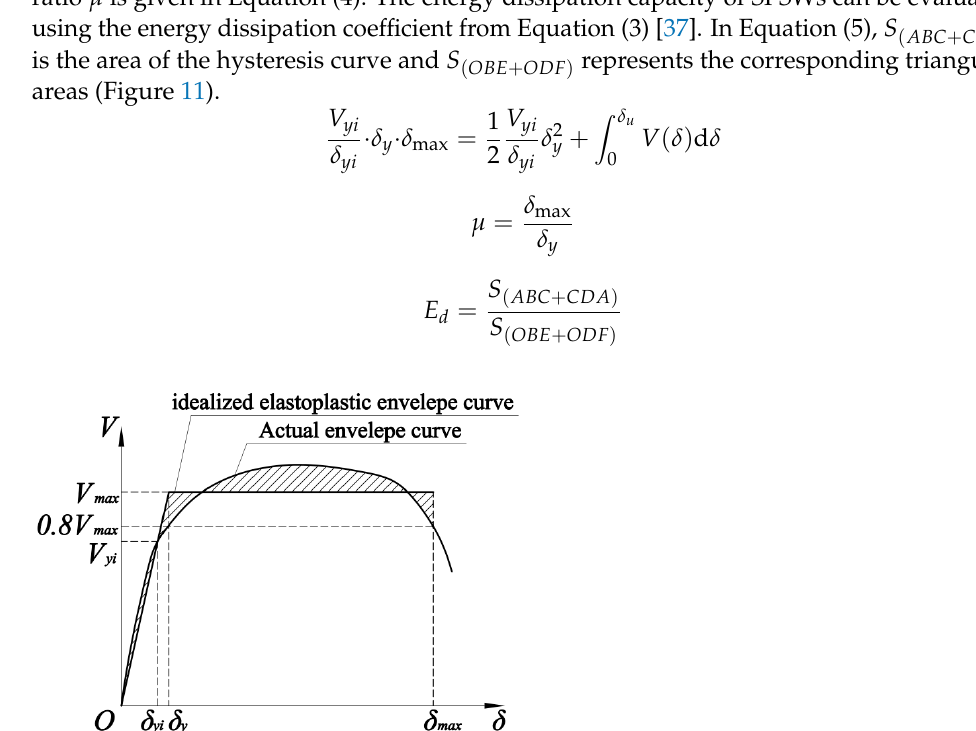
Figure 11. De fi nition of the energy dissipation coe ffi cient. 𝑉 (cid:3052)(cid:3036) 𝛿 (cid:3052)(cid:3036) ∙ 𝛿 (cid:3052) ∙ 𝛿 (cid:2923)(cid:2911)(cid:2934) = 1 2 𝑉 (cid:3052)(cid:3036) 𝛿 (cid:3052)(cid:3036) 𝛿 (cid:3052)(cid:2870) + (cid:3505) 𝑉(𝛿)d𝛿 (cid:3083) (cid:3296) (cid:2868)